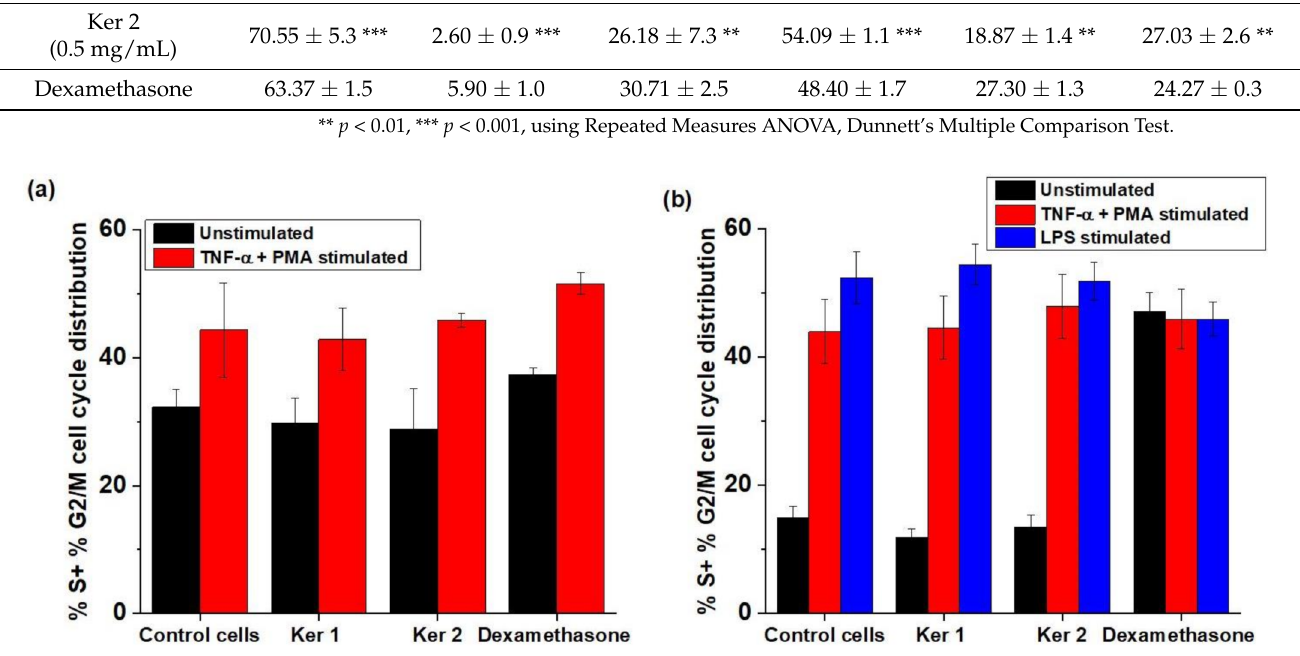
Figure 6. Mitotic phases’ evolution modulated by the lyophilized keratins: ( a ) HS27, ( b ) HaCaT (differences between cells treated with Ker1, Ker2 and positive control were done using ANOVA test— 95% significant level on each pair of interest and differences at p < 0.05 were considered statistically